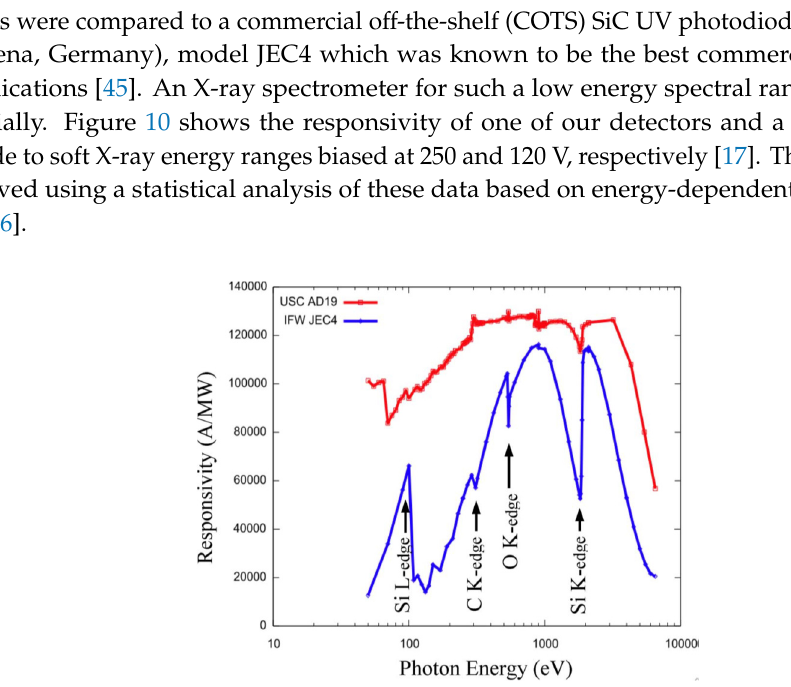
( b ) Figure 11. ( a ) Responsivity of the detectors on 4H-SiC n-type epitaxial layer at two different locations and ( b ) surface scan profiles along line L obtained to assess the detector’s uniformity. Our detectors also exhibited very good spatial uniformity in measured responsivity. Figure 11b shows responsivity at two different locations and line scan profiles for two different X-ray energies. Note that the decrease of the detector’s current at about 0 mm (Figure 11b) is due to the crossing of